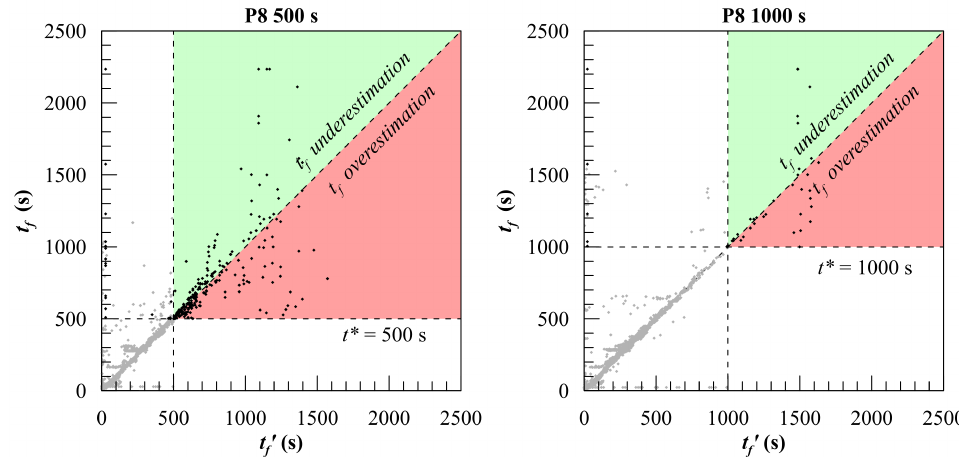
Figure 12. Predicted over observed values of the time-to-flood computed at t ∗ = 500 s and t ∗ = 1000 s. Training: P8; validation: MC50b; method: